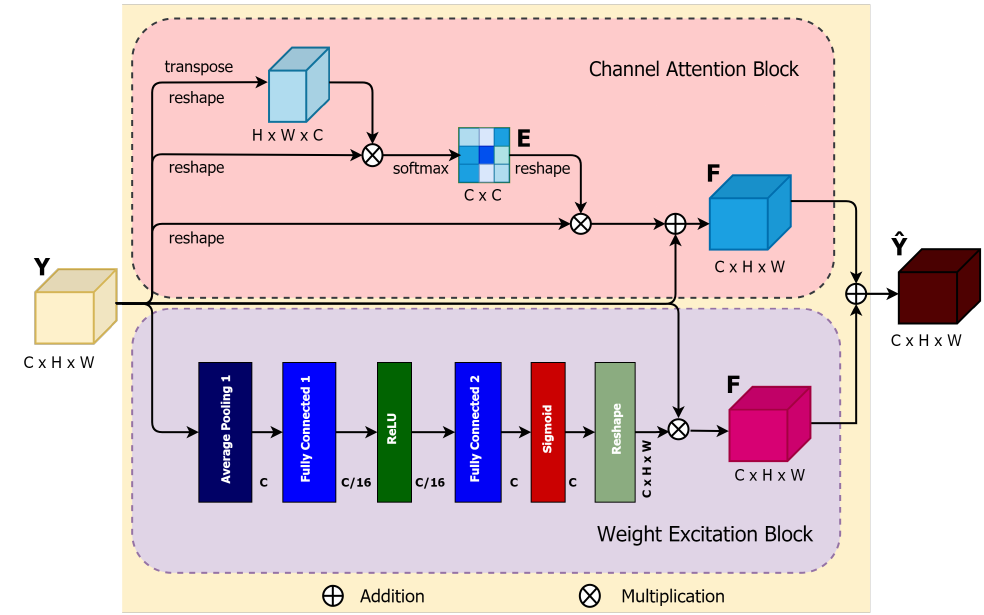
Figure 5. Illustration of the proposed CAWE